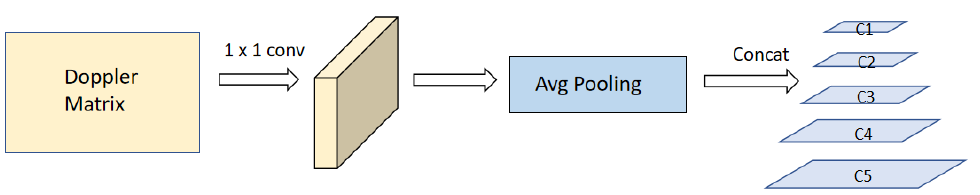
Figure 8. Feature